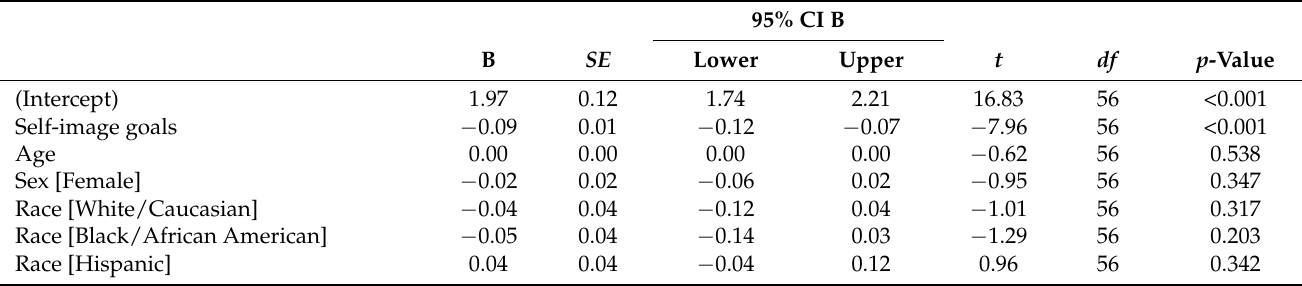
Table 5. Complex Samples General Linear Model with Self-Image Goals Predicting